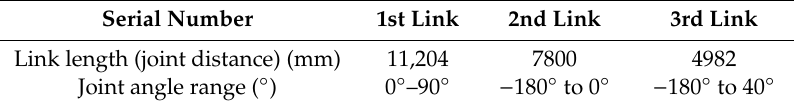
Table 1. Parameters of 24m-3R mobile concrete pump manipulator.